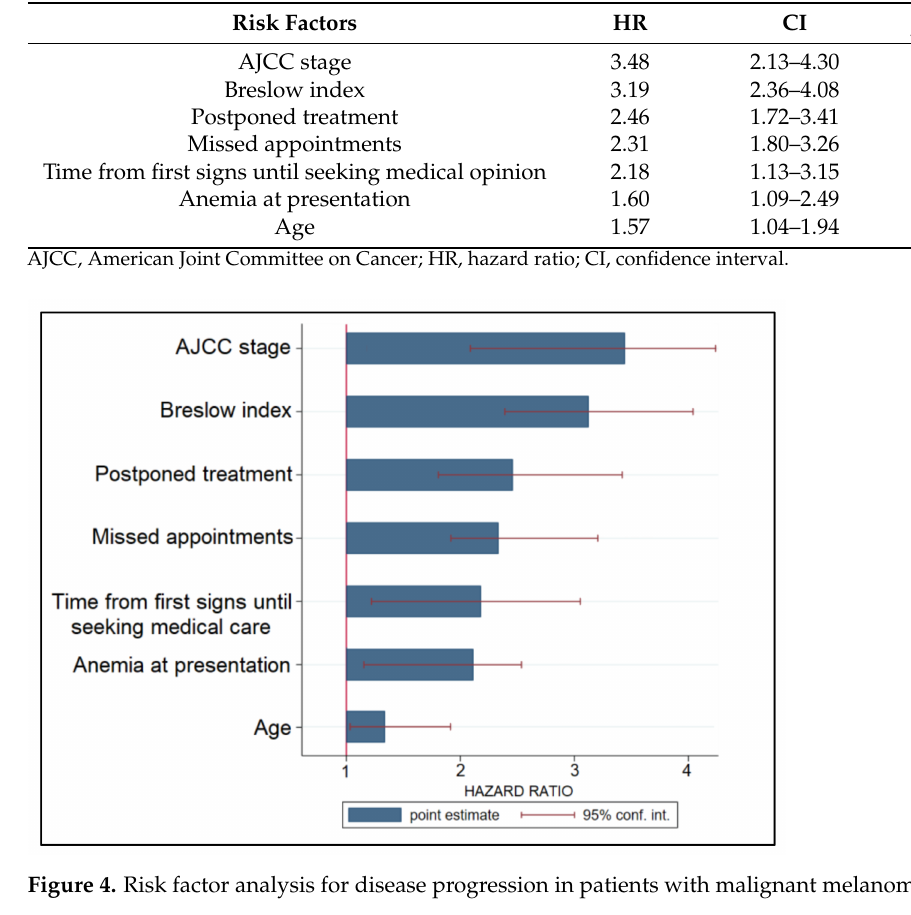
Table 4. Risk factors for melanoma progression after the initial hospital visit.